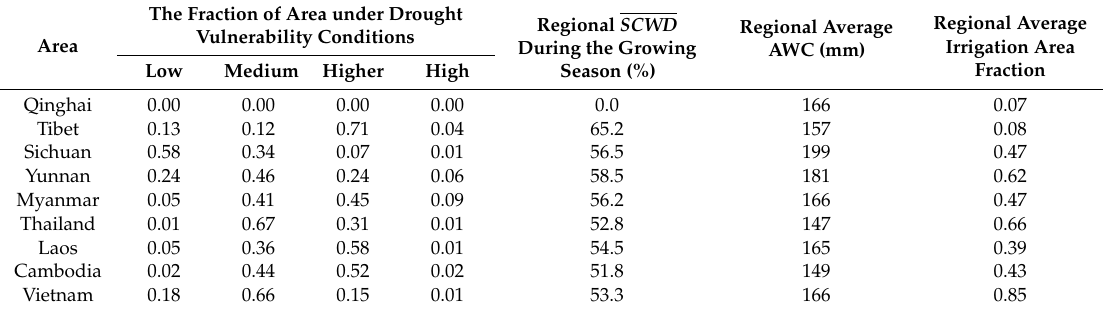
Table 6. Regional di ff erences of drought vulnerability in the LMR.